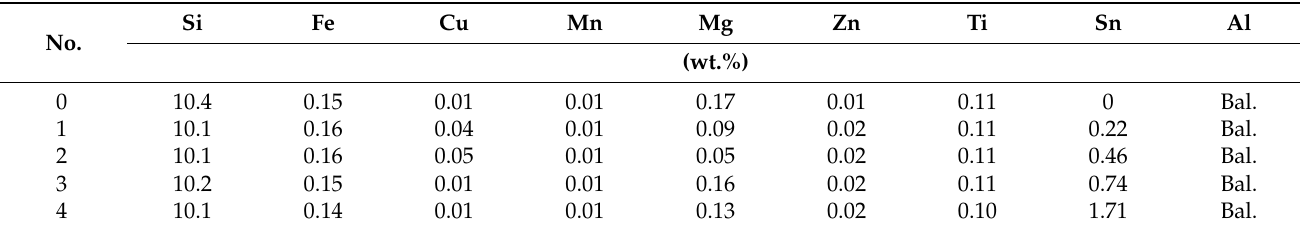
Table 1. Chemical composition of AlSi10 alloys with tin